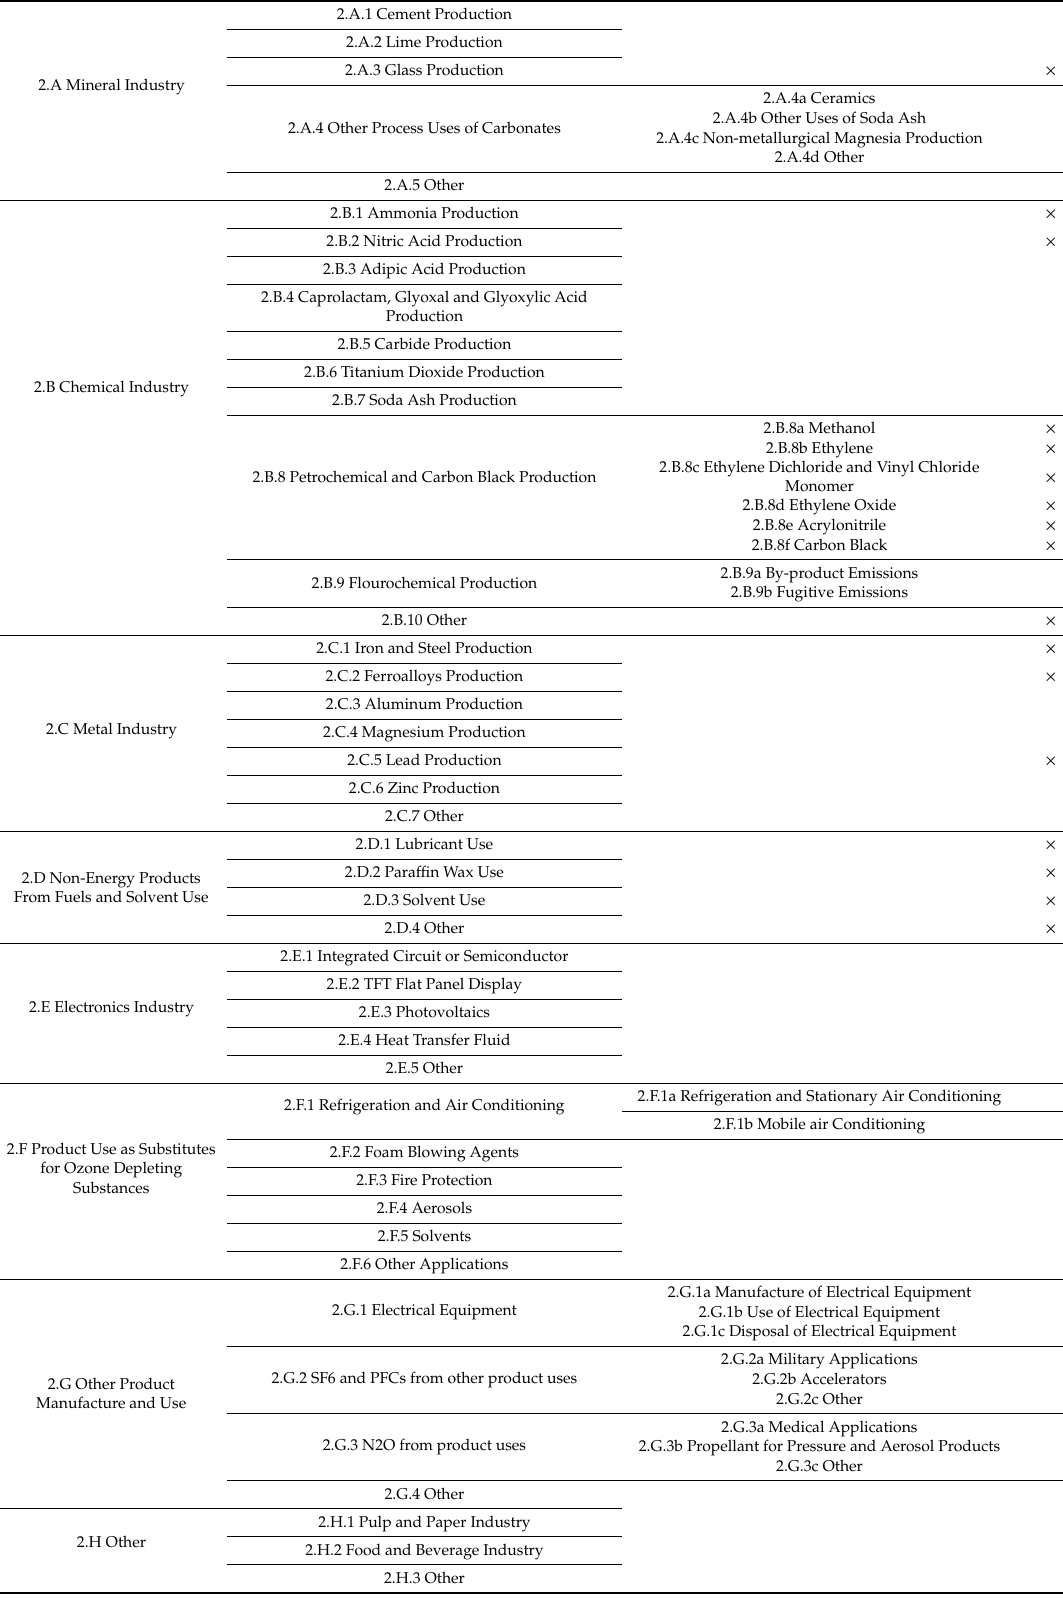
Table 2. List of subcategories of the industrial processes and other product use (IPPU) sector